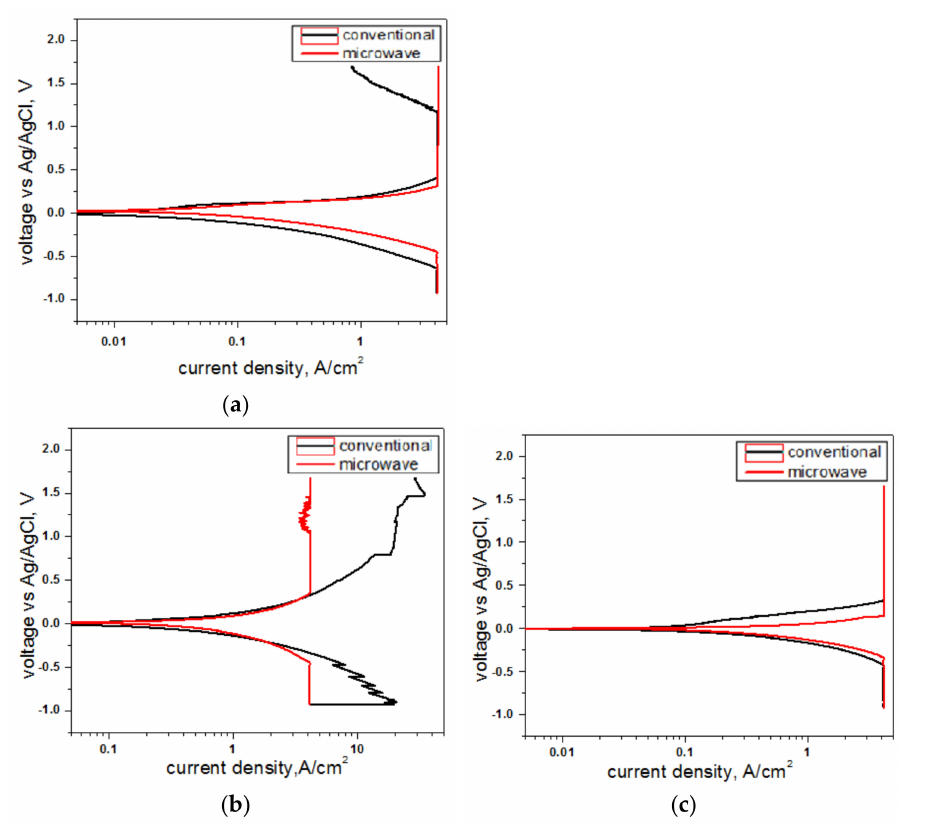
Figure 4. Comparison of the potentiodynamic polarization curves of conventionally and Microwave sintered ( a ) Al-22.5%Mn, ( b ) Al-18.6%Cu-24.12%Mn, and ( c ) Al-20%Cu-15%Mn